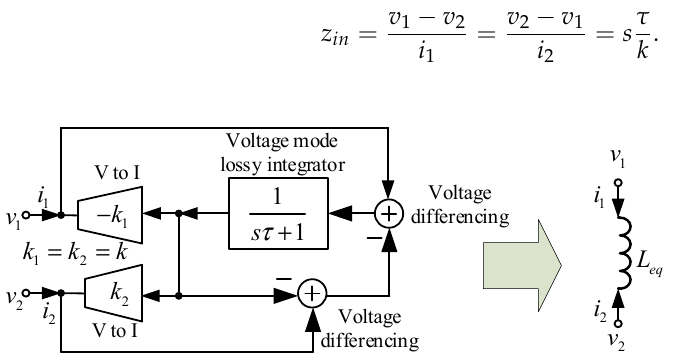
Figure 13. Block diagram presenting the synthesis of the floating lossless inductance simulator.